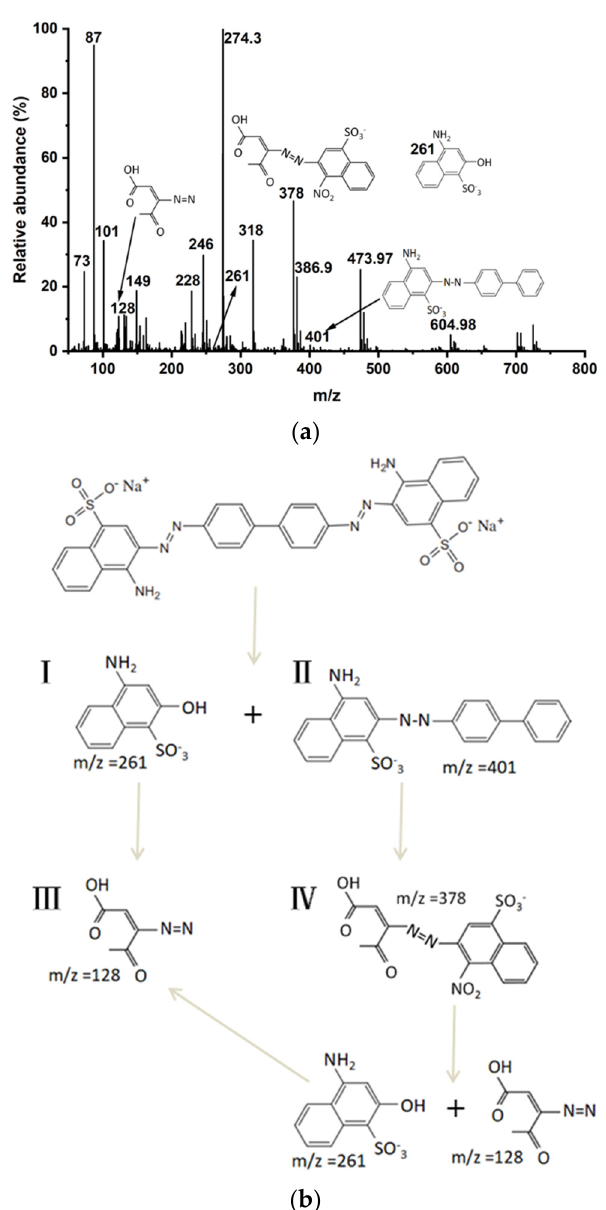
Figure 13. ( a ) MS spectra of Congo red dye solution after treatment with catalyst; ( b ) Product formation from the degradation of CR dye.